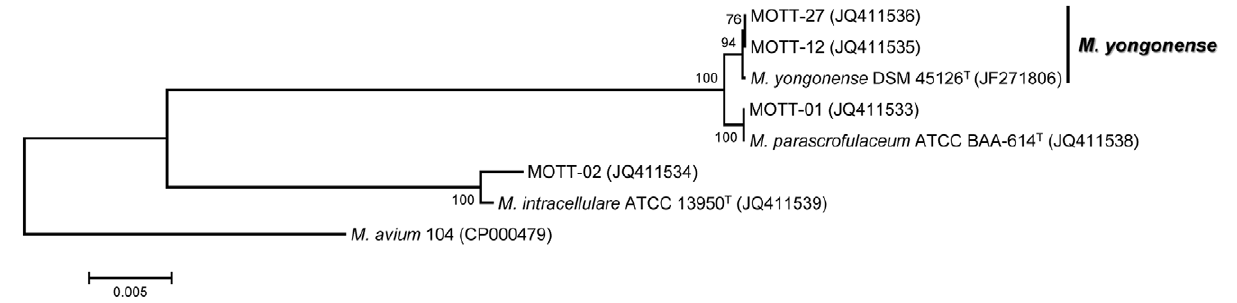
Figure 1. Phylogenetic relationships based on the full rpoB gene ( 3447 or 3450 bp ) sequences. This tree was constructed using the neighbor-joining method. The bootstrap values were calculated from 1,000 replications; bootstrap values of , 50% are not